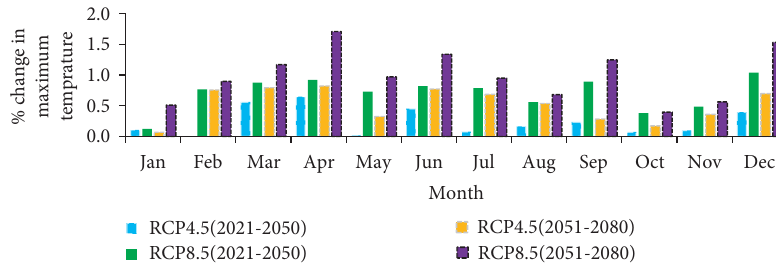
Figure 11: Change in average monthly maximum temperature.